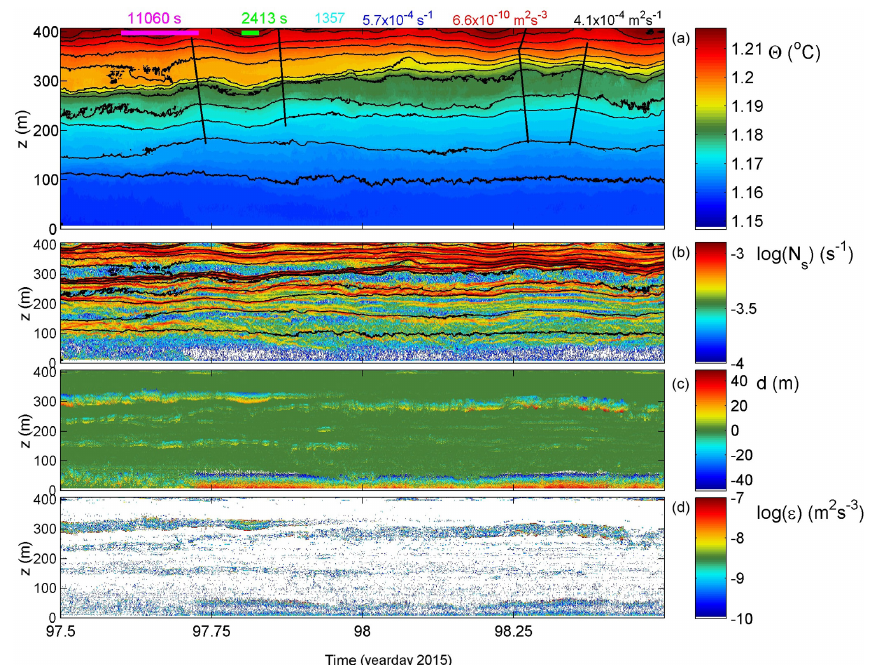
Figure 5. As Fig. 3 with identical colour ranges, but for a 1-day period with more intense turbulence, especially near the